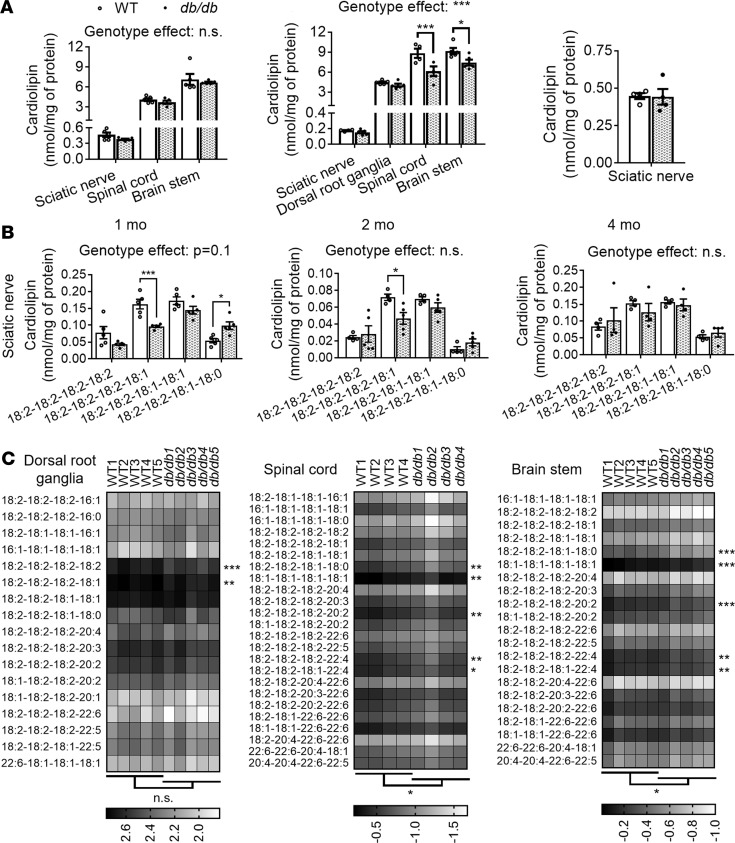
Impaired cardiolipin homeostasis in the PNS and CNS of obese diabetic mice.Sciatic nerve, DRG, spinal cord, and brainstem were dissected from 1-, 2-, and 4-month-old WT and db/db male mice, flash-frozen, homogenized, and lipid extracted. MDMS shotgun lipidomics was used to assess cardiolipin content (A) and composition (B and C) in different PNS and CNS regions. Graphs are presented as dot plots; data represent the mean ± SEM of n = 4–5 mice/genotype. WT (open circles/bars) and db/db (filled circles/bars). Cardiolipin molecular species for DRG, spinal cord, and brainstem of 2-month-old mice are presented as gray scale heatmaps (data were log transformed) (C). Low-abundance lipid species that made ≤1.5% of the total class content are not shown and were not included in statistical analyses. Although a specific mass peak may represent >1 cardiolipin molecular species, for simplicity heatmaps display only 1 lipid species (usually the most common) for each peak/row. Total cardiolipin levels were compared between genotypes for each region/time point using unpaired 2-tailed t tests. Molecular species within each lipid class were compared using 2-way ANOVA and Holm-Šidák multiple-comparisons test on GraphPad Prism 7. Statistics displayed below the heatmaps comparing genotypes and next to the molecular species are based on nontransformed data. *P < 0.05, **P < 0.01, ***P < 0.001.